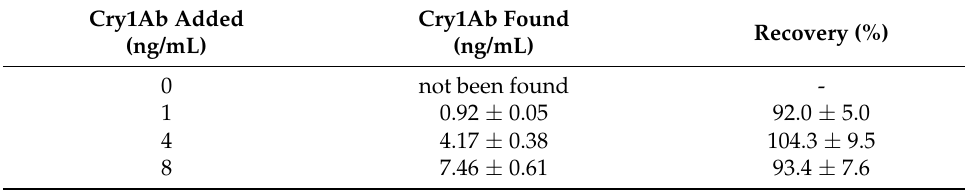
Table 2. Recoveries of